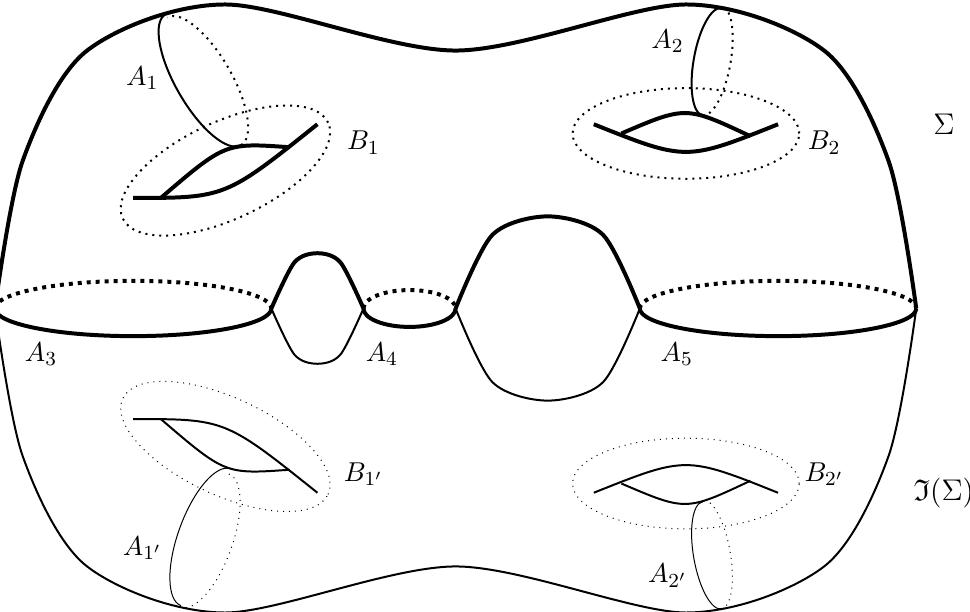
Figure 9 . A surface (cid:6) of genus g = 2 and (cid:23) = 3 boundary components A 3 ; A 4 ; A 5 , along with its double surface without boundary ^(cid:6) = (cid:6) [ I ((cid:6)) of genus ^ g = 6. There is one further boundary component, A